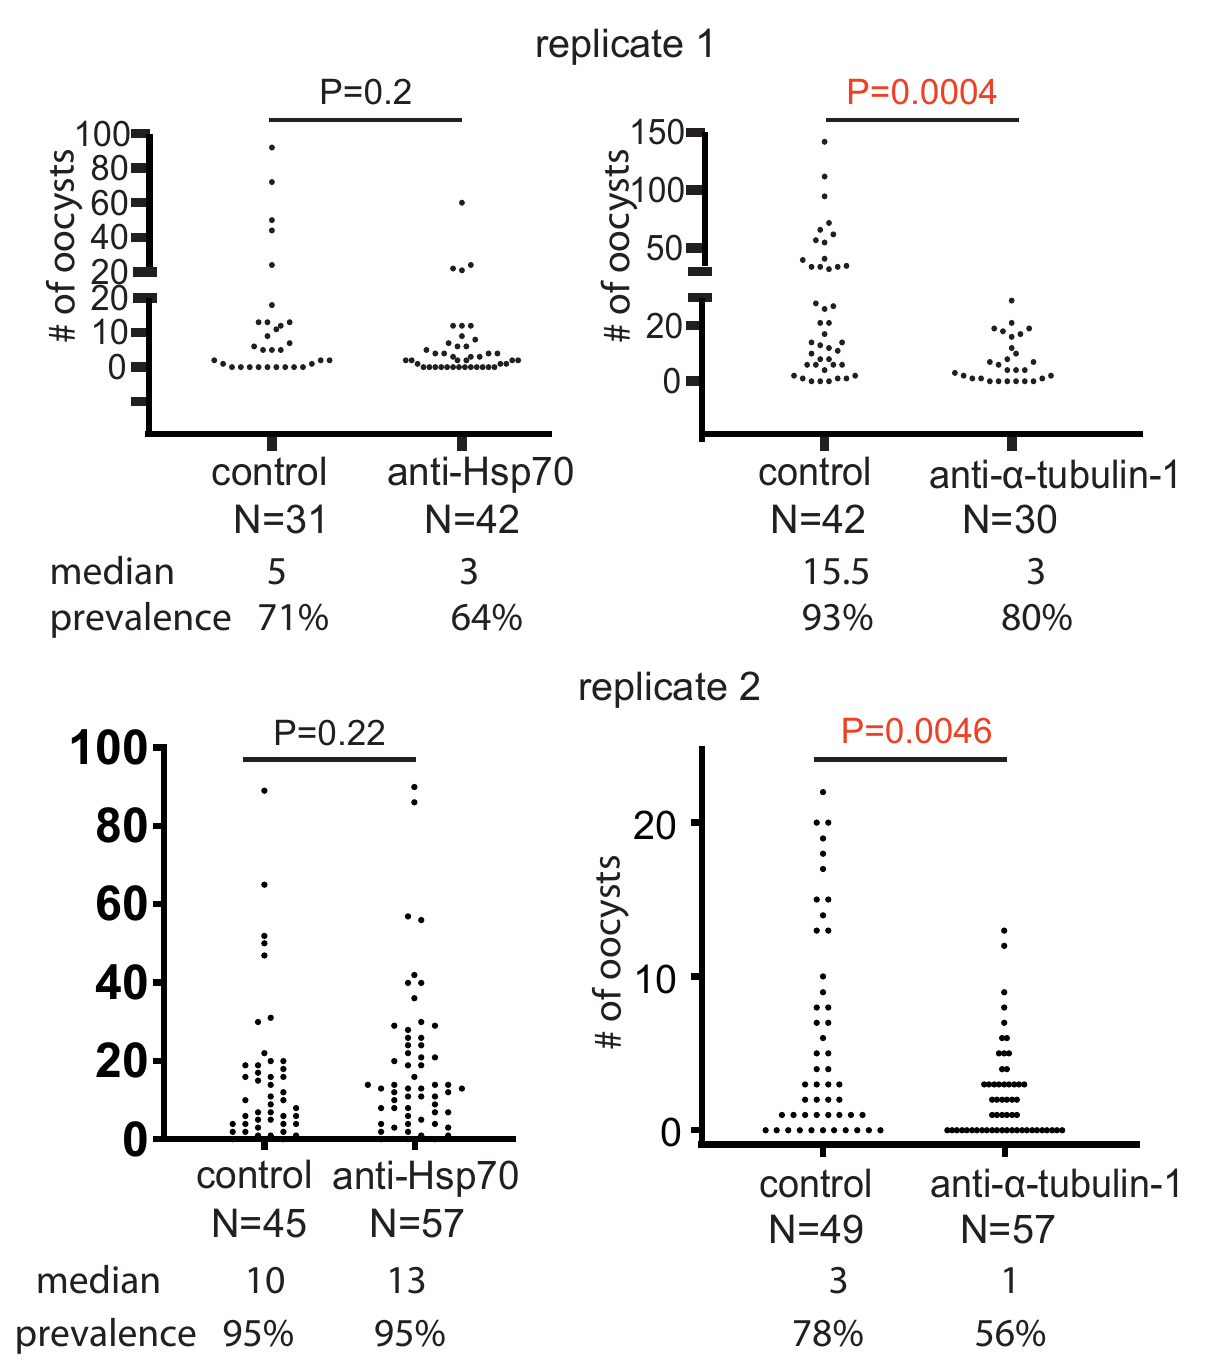
not observe any strong interaction signals, suggesting that mAb A3 recognized a conformational epitope or an epitope formed by a peptide longer than 14 amino acids (Figure 6).